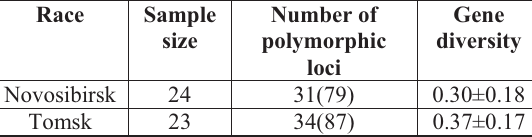
Table 1. Summary statistics of the sample sizes, number and % (in parentheses) of polymorphic loci and Nei’s (1973) index of gene diversity for the Novosi- birsk and the Tomsk chromosome